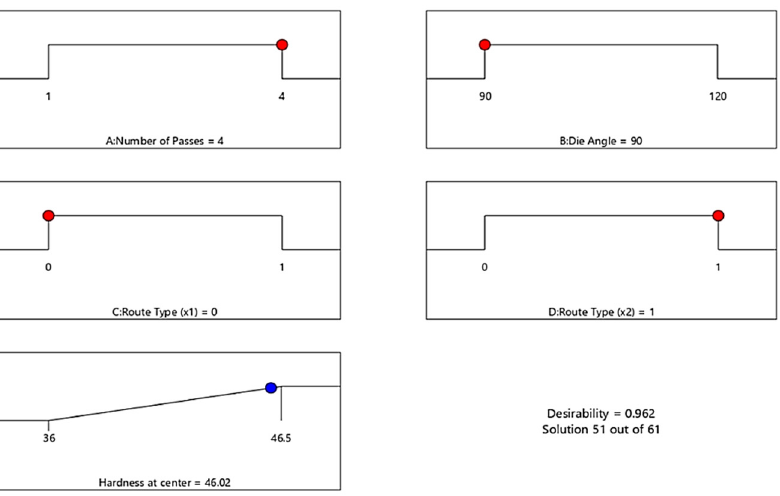
Figure 12. Optimal ECAP process parameter of H c . Red dots: ECAP condition. Blue dots: ECAP response.